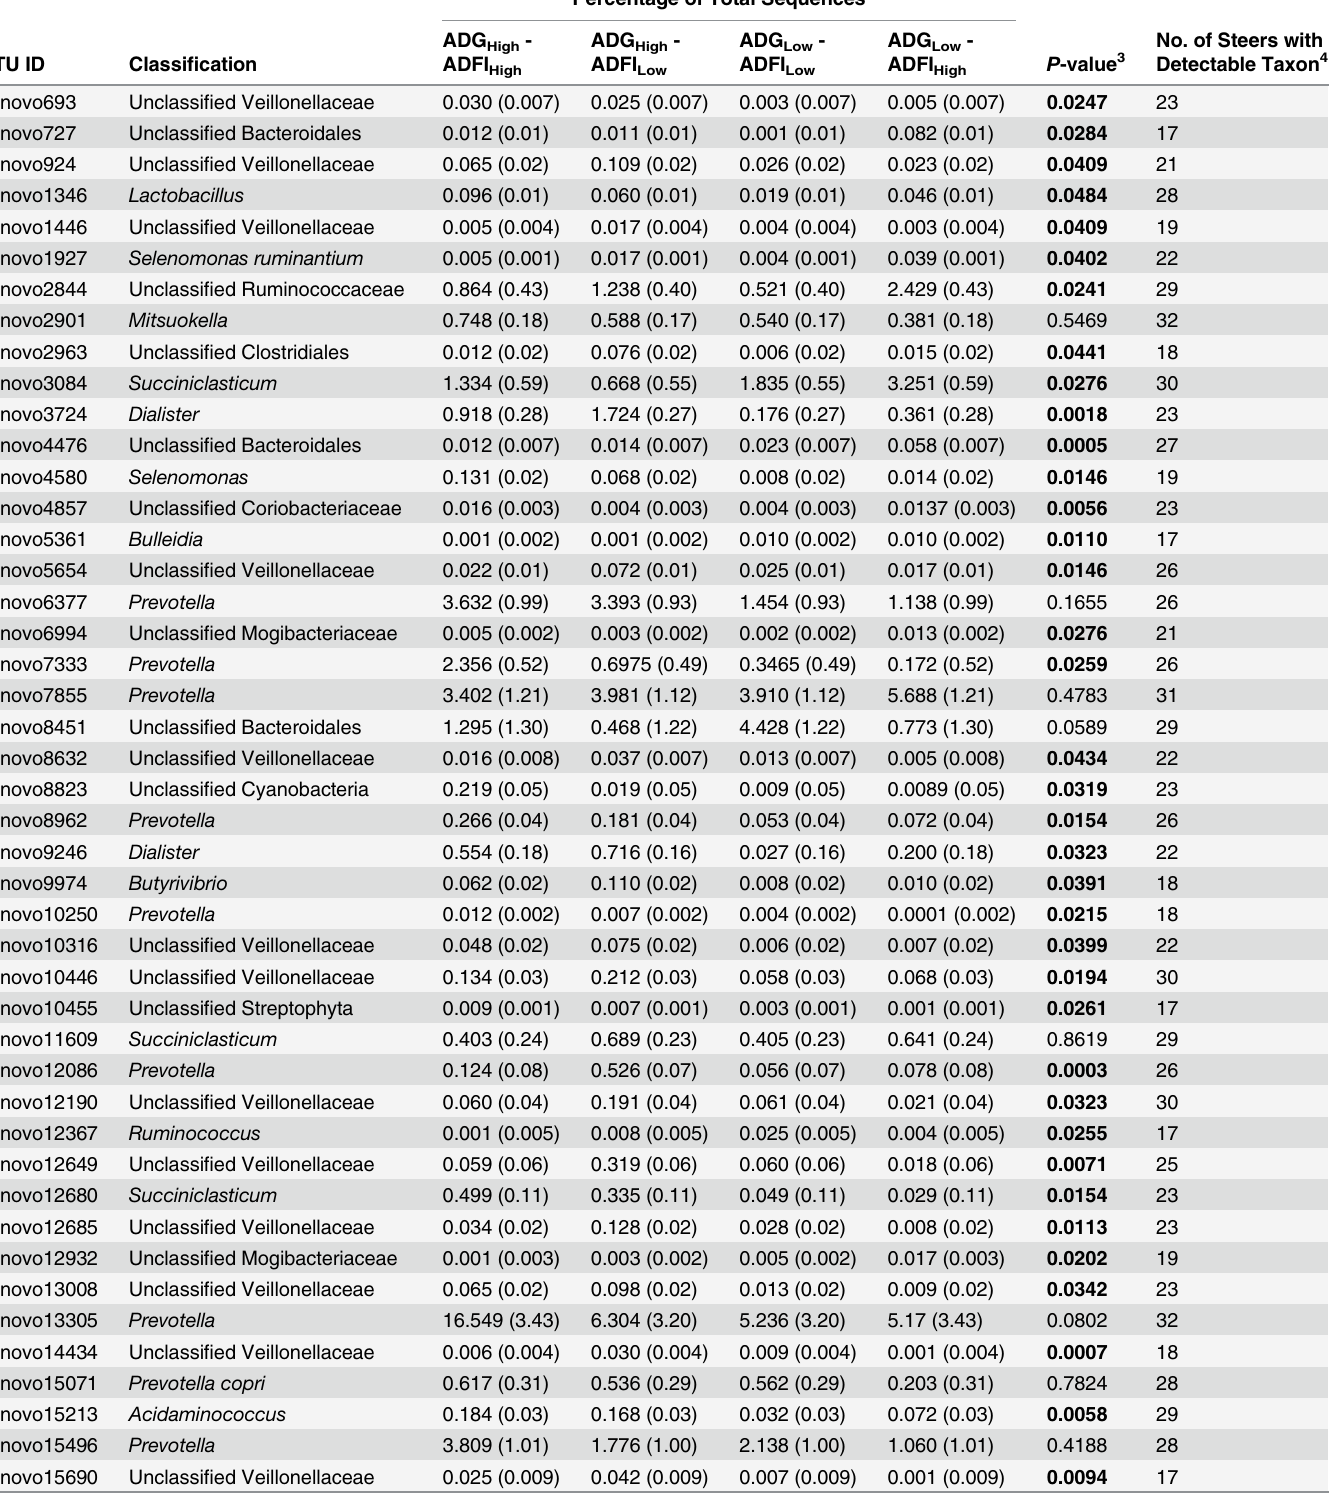
Table 3. Relative abundance of OTUs in the four